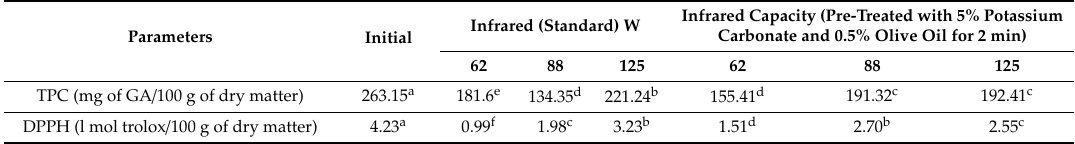
Table 3. Total phenols and antioxidant e ffi cacy of infrared dried jujube [53].